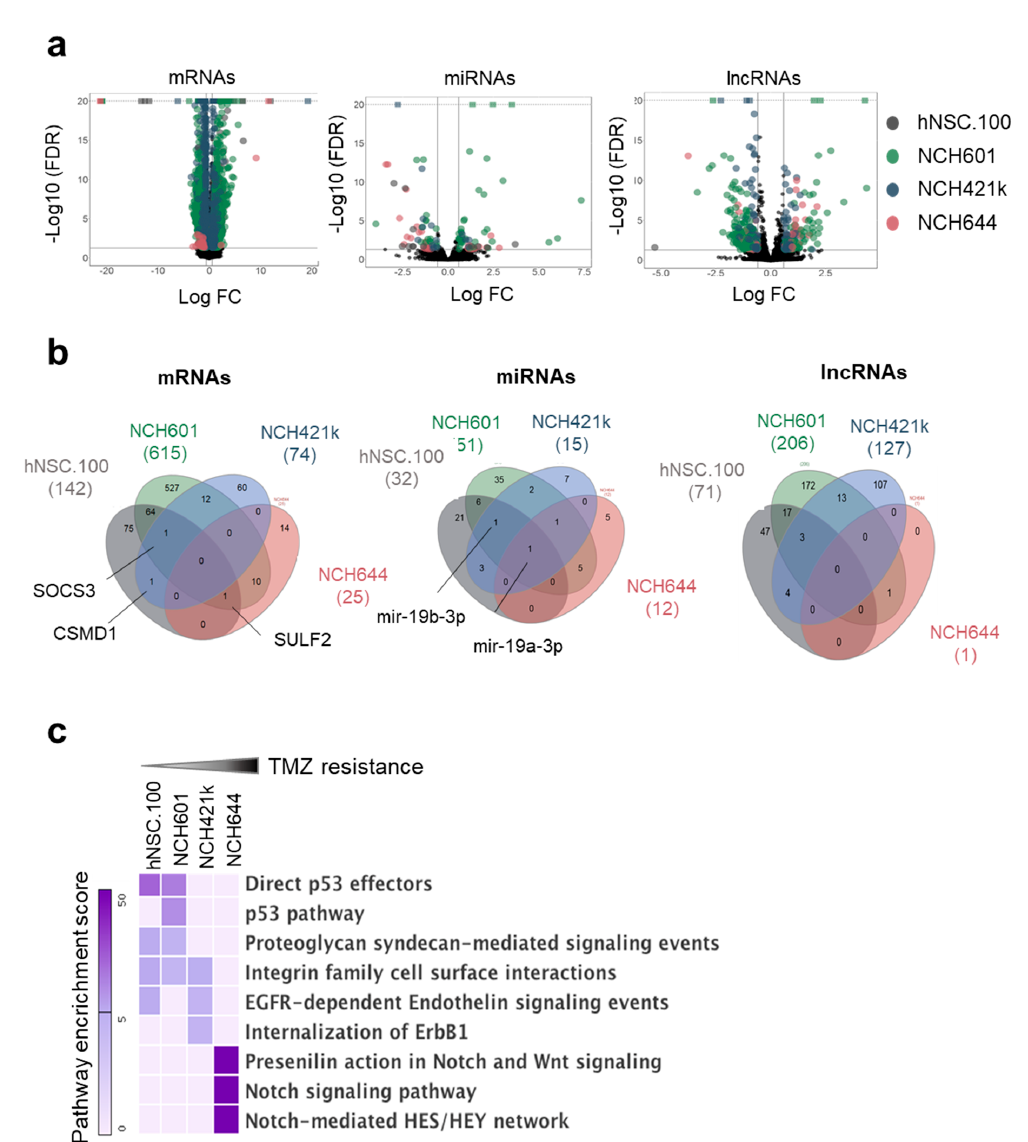
Figure 2. Genome-wide transcriptional changes induced by TMZ in GSCs. ( a ) Volcano plots representing the TMZ-regulated RNA subclasses in three GSCs (NCH601, NCH421k, NCH644) and one control neural stem cell line (hNSC.100): mRNAs (left panel), microRNAs (middle panel), lncRNAs (right panel). Each differentially expressed gene is represented by a dot and cell lines are indicated by different colors. Cut-offs for differential expression: FDR < 0.05 and absolute log FC > 2 for mRNAs, and FDR < 0.05 and absolute log FC > 1.5 for non-coding RNAs. Genes not satisfying these criteria are in black. For visualization purposes, the vertical axis has a limit of -log10 (FDR) = 20. ( b ) Venn diagrams showing the intersection of RNAs regulated by TMZ from the four cell lines. ( c ) Heat map representing the enrichment score of the top three pathways associated with mRNAs regulated by TMZ in each cell line.